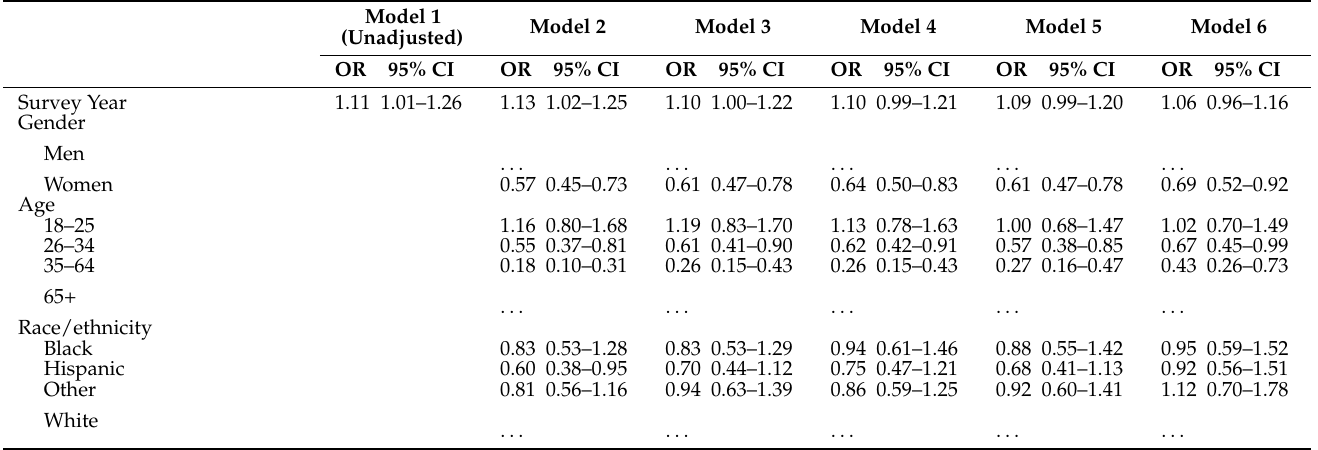
Table A3. Test of trends in cannabis use among adults with heart disease: pooled sample of